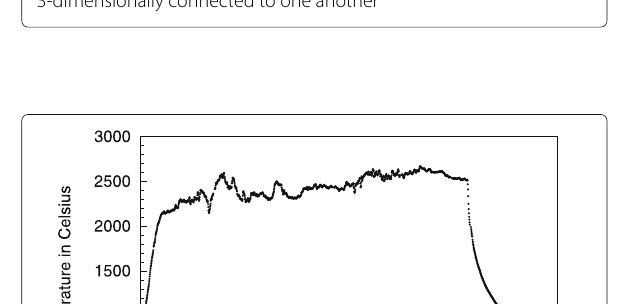
range in diameter is 9-390 μ m, and were sorted into size bins of every 5 μ m width for a normal-scale histogram (Fig. 5a). The same droplets were size-sorted into com- mon log-scale bins of every 0.065 width (Fig. 5b). The result is a log-normal-like distribution, which is gener- ally recognized as a typical size-frequency distribution of chondrules (Friedrich et al. 2015). In a similar manner,